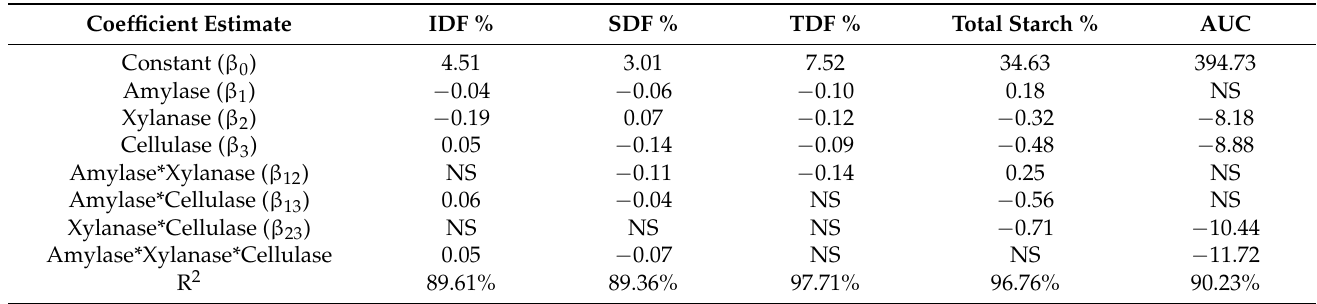
Table 4. Estimated regression coefficients of factors.